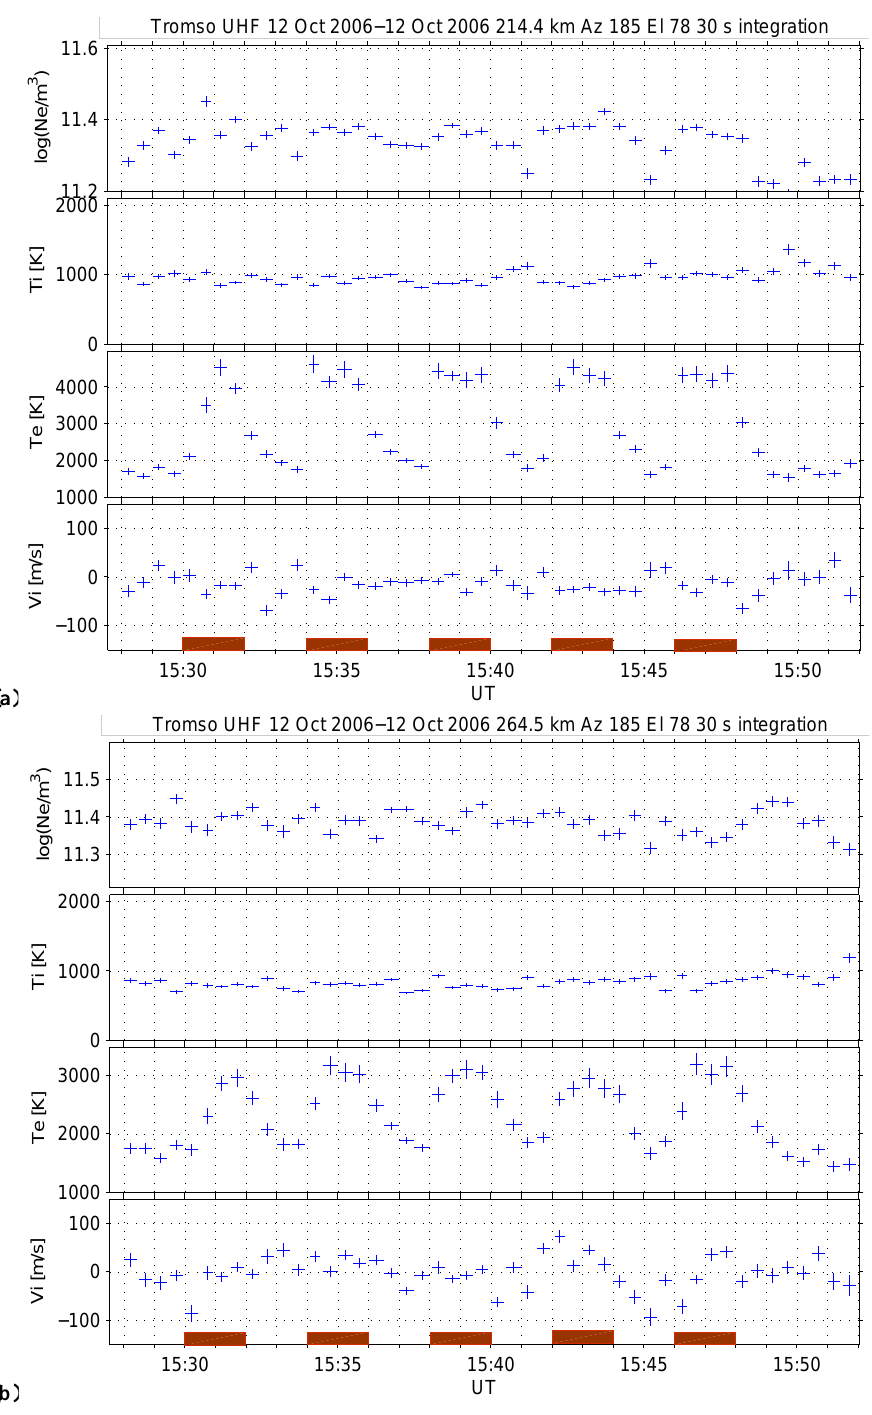
Fig. 11b Fig. 11. Temporal variations of the electron density, N e , ion and electron temperatures, T i and T e , and the ion velocity, V i , from the EISCAT UHF radar observations on 12 October 2006 from 15:28 to 15:52UT at different altitudes: (a) 214km; (b) 264km. suprathermal electrons. These suprathermal electrons pro- duce enhanced optical emissions at 557.7 (Bernhardt et